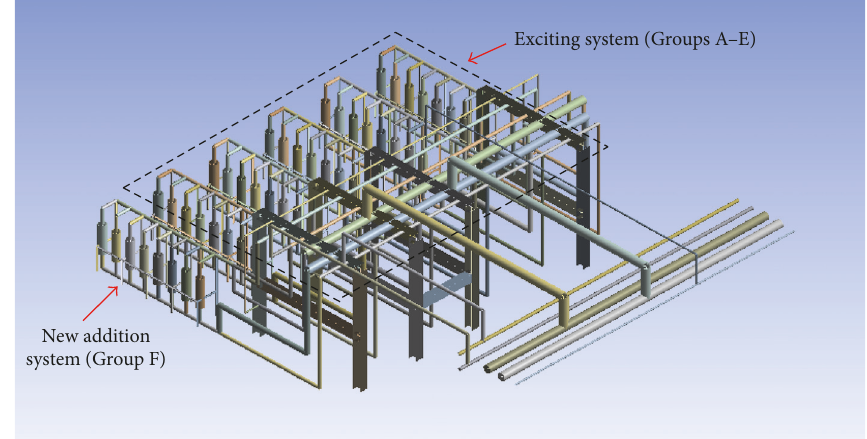
Figure 1: The exciting and addition filter